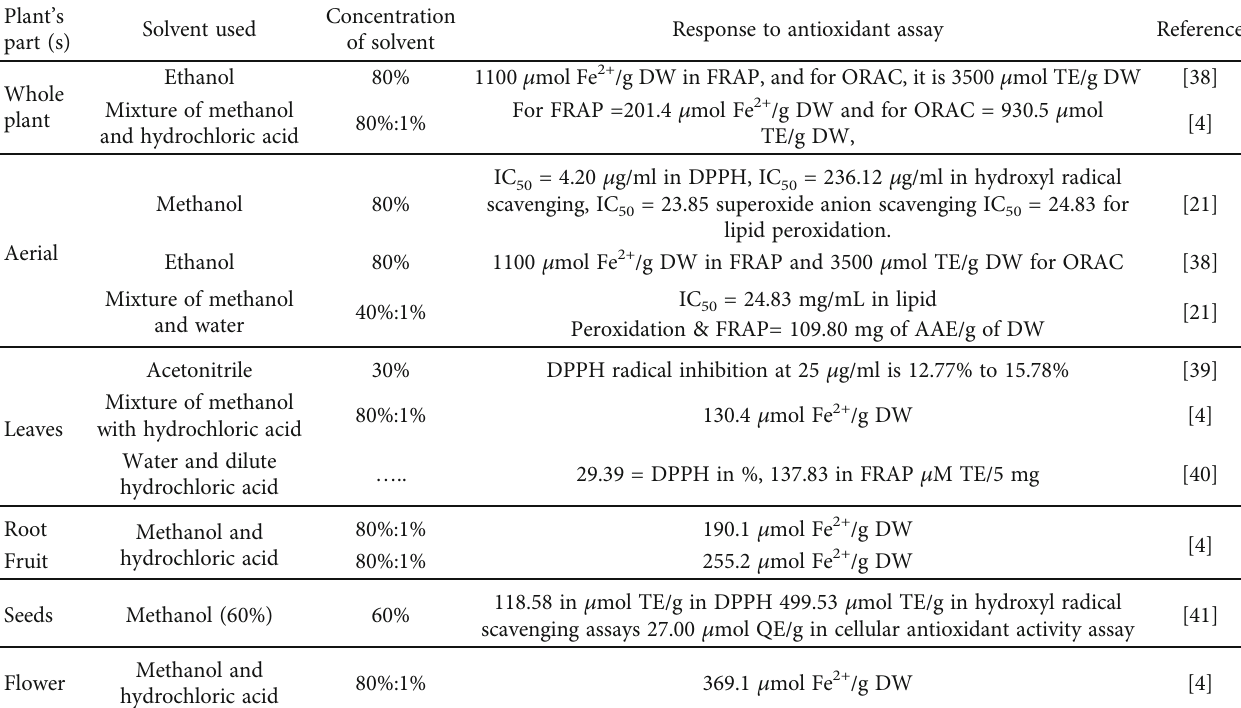
Table 2: Antioxidant behaviors of di ff erent parts of the